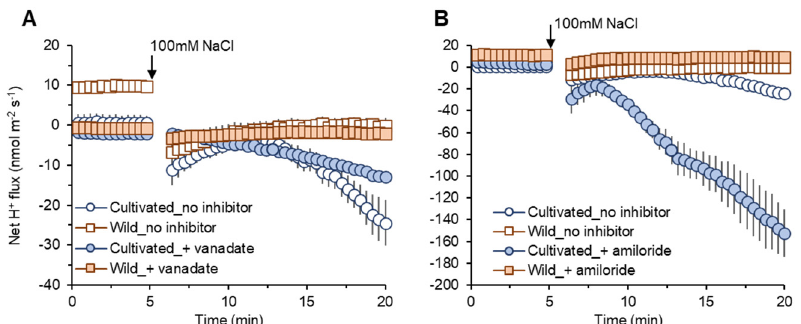
Figure 7. Transient net H + flux measured from mature root zones of cultivated and wild rice species in response to 100 mM NaCl application with 1 h of pre-treatment of known inhibitors: 1 mM sodium orthovanadate (vanadate), H + -ATPase blocker ( A ); 0.1 mM amiloride, an inhibitor of Na + /H + exchanger ( B ). Mean ± SE ( n = 5–6).